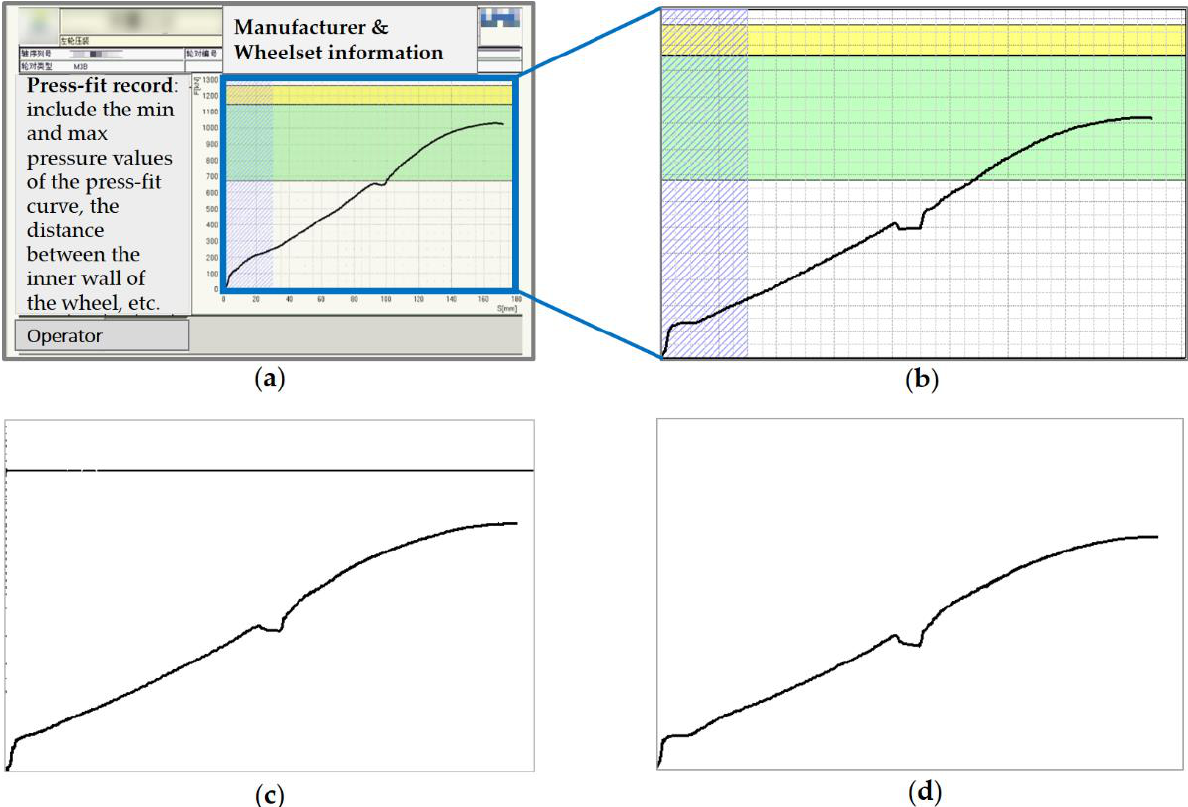
Figure 4. An output diagram of each stage in the image-preprocessing process. ( a ) The original image of the recording press-fit information output by NC wheelset assembly machines; ( b ) The ROI of the press-fit curve was cropped from the original image; ( c ) The initial binarization result of ( b ); ( d ) The final result after postprocessing.